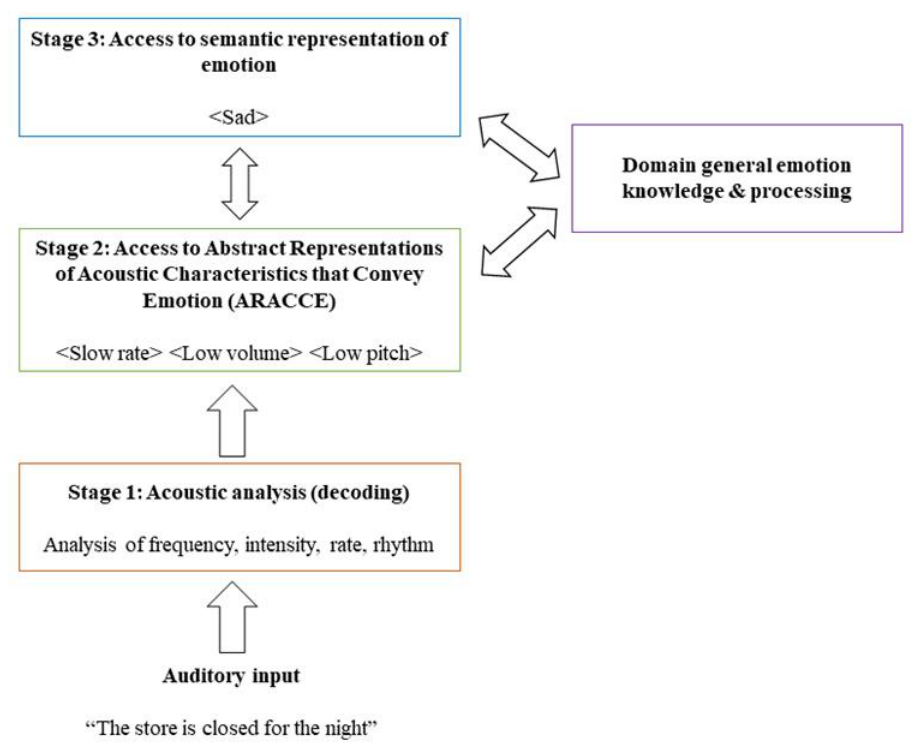
Figure 1. Model of affective prosody recognition as described by Wright et al. [2] and further refined by Sheppard et al. [23]. The model includes the three proposed stages underlying affective prosody recognition as well as an interactive loop between Stages 2 and 3. A description and example processing is included at each model stage. Not yet considered in the model are domain-general cognitive processes (e.g., attention, executive functioning, working memory) that interact and support successful affective prosody